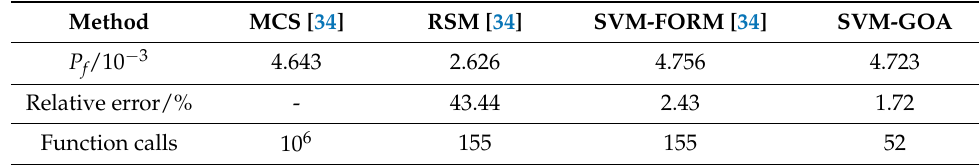
Table 10. Comparison of calculation results of Case 4.